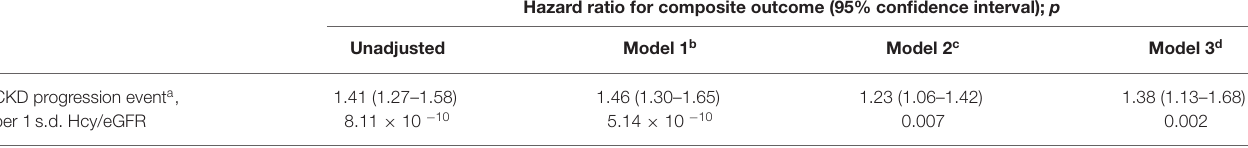
TABLE 2 | Hcy/eGFR ratio as a risk factor for the composite kidney disease progression event in IgAN. Hazard ratio for composite outcome (95% confidence interval); p Unadjusted Model 1 b